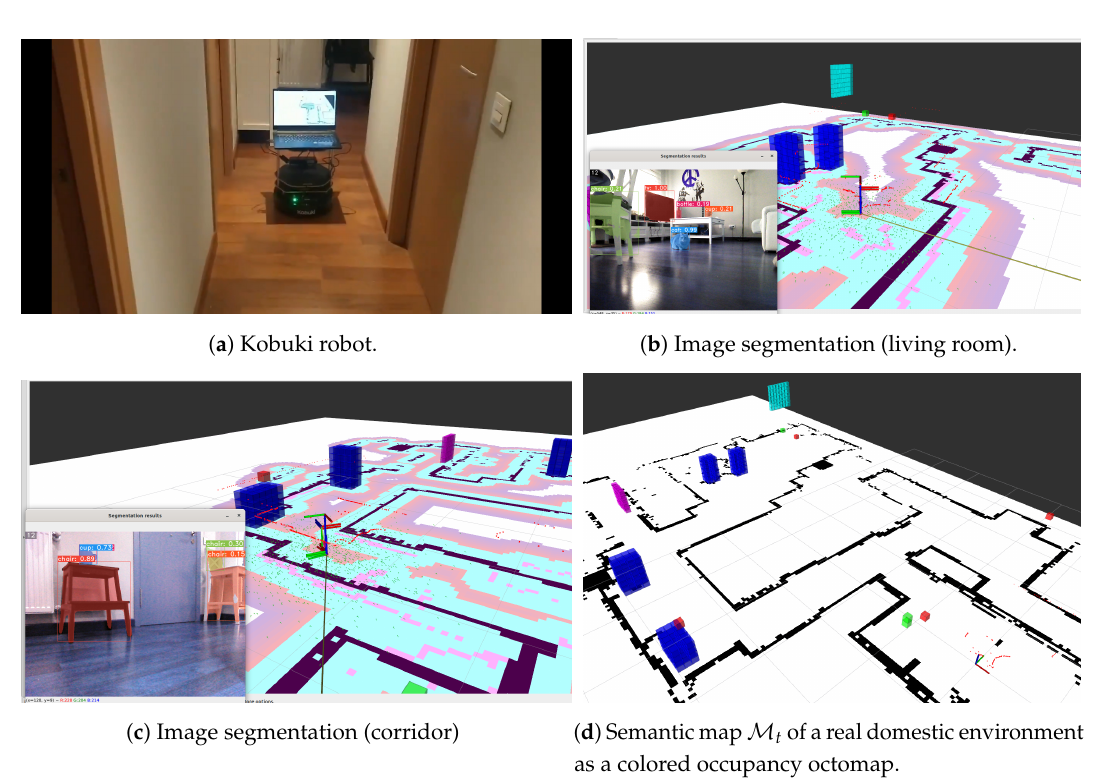
Figure 11. Mapping of a real domestic